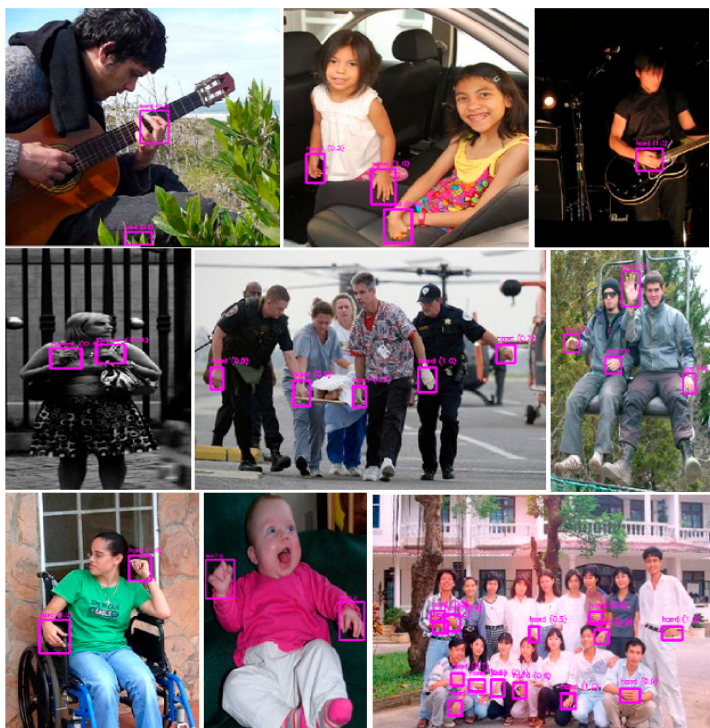
Figure 8. The detection results of Yolo V4 CSP SPP on the Oxford hand